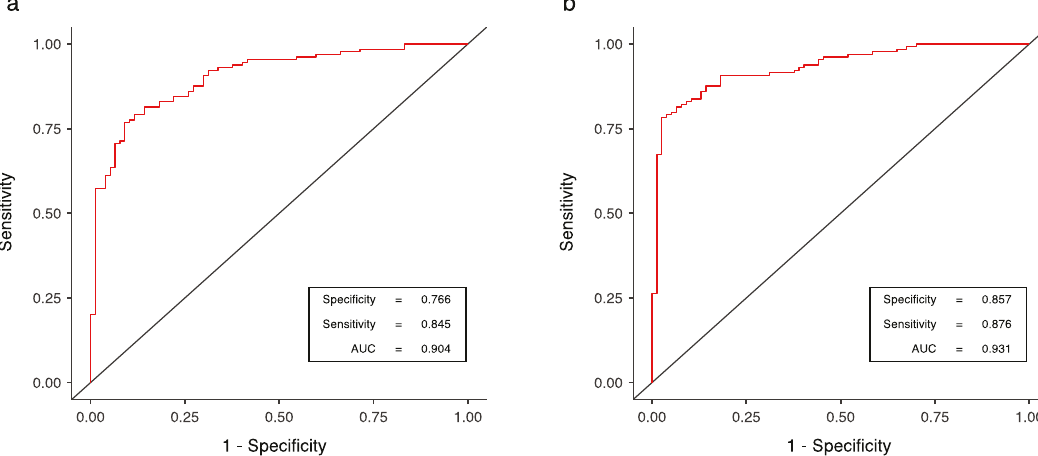
Fig. 2 ROC curves from logistic regression of TL and mtDNAcn between BD and HC. Logistic regressions (BD versus HC) were performed with either TL ( a ) or mtDNAcn ( b ), with an adjustment for covariates (age, sex, BMI, current tobacco use, MADRS, and the BD group, a majority of individuals had been diagnosed with BD type 1 (75.4%). Comparisons of BD and HC groups for TL and mtDNAcn TL and mtDNAcn were positively correlated in individuals with BD (rho = 0.221; p = 0.011) but not in HC (rho = 0.044; p = 0.701). TL was negatively correlated with age in both BD and HC groups (respectively rho = − 0.362 and rho = − 0.392; p < 0.001), but mtDNAcn was not correlated with age (rho = − 0.160, p = 0.069 for BD and rho = 0.101, p = 0.377 for HC) (Fig. S1). Univariate analyses (Mann – Withney tests) showed that TL and mtDNAcn were both lower in BD as compared to HC (reduction of 26.5% for TL p < 0.001 and reduction of 35.8% for mitDNAcn p < 0.001). These differences between groups remained signi fi cant (both p values <0.001) after adjustment for age, sex, BMI, MADRS scores, YMRS scores, and smoking status in linear regressions (Fig. 1 and Table S1). Logistic regressions (BD versus HC) adjusted for potential covariates (Table S2) and ROC analyses (Fig. 2) indicated that each marker signi fi cantly discriminated BD from HC (for TL: speci fi city = 0.766; sensitivity = 0.845; AUC = 0.904 and for mtDNAcn: speci fi city = 0.857; sensitivity = 0.876; AUC = 0.931).